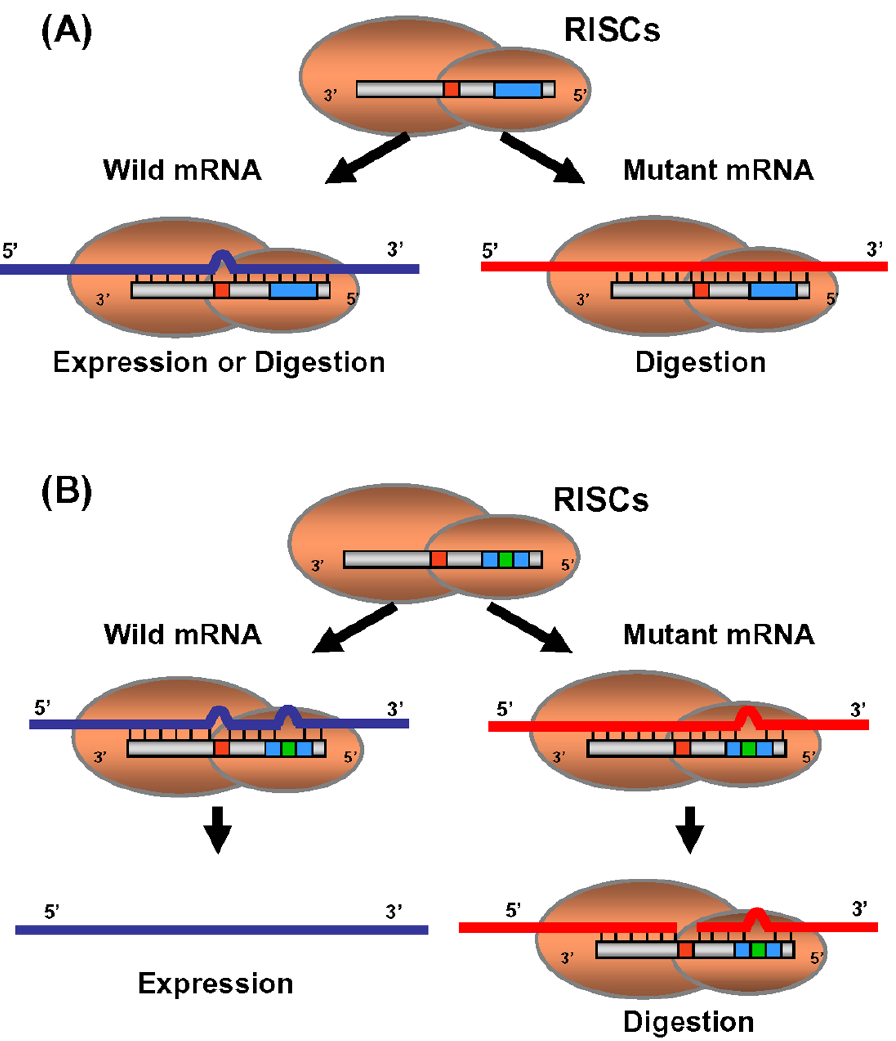
Figure 6. Schematic summary of allele-specific gene silencing with mismatched siRNA. Guide siRNA elements in RISCs are indicated by gray bars, in which nucleotide variation and the seed region are indicated by red and blue boxes, respectively. Introduced base substitutions are indicated by green boxes. Mutant and wild-type allelic transcripts are indicated by red and blue lines, respectively. (A) When designed siRNA targeting the mutant allele has potential for potent gene silencing, not only the mutant but also the wild-type alleles may be inhibited by RNAi mediated by the siRNA, i.e., double knockdown against both alleles may occur. (B) When a one-base substitution is introduced into the seed region of an siRNA conferring double knockdown, the resultant (guide) siRNA generates one and two mismatches against the mutant and wild-type alleles, respectively, thereby possibly gaining the ability to induce ASP-RNAi.